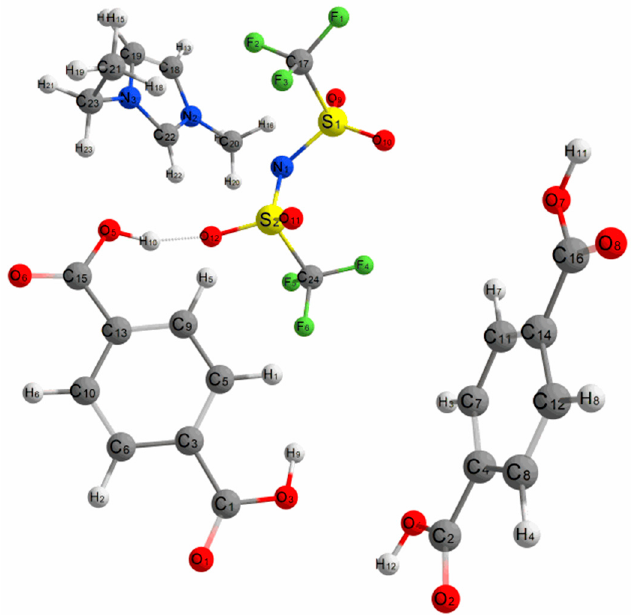
Figure 15. The optimized structure of UiO-66 and [EMIM][TFSI].